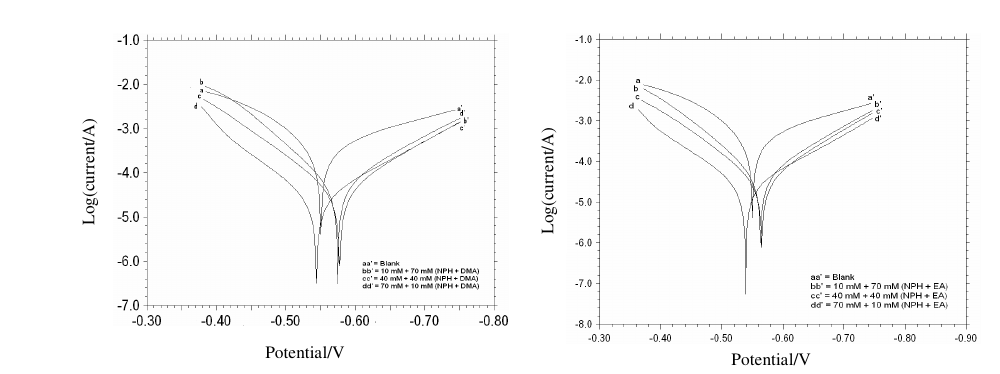
Figure 3. Potentiodynamic polarization curves in absence and in presence of the binary inhibitor mixtures of NPH and EA at different concentration ratio